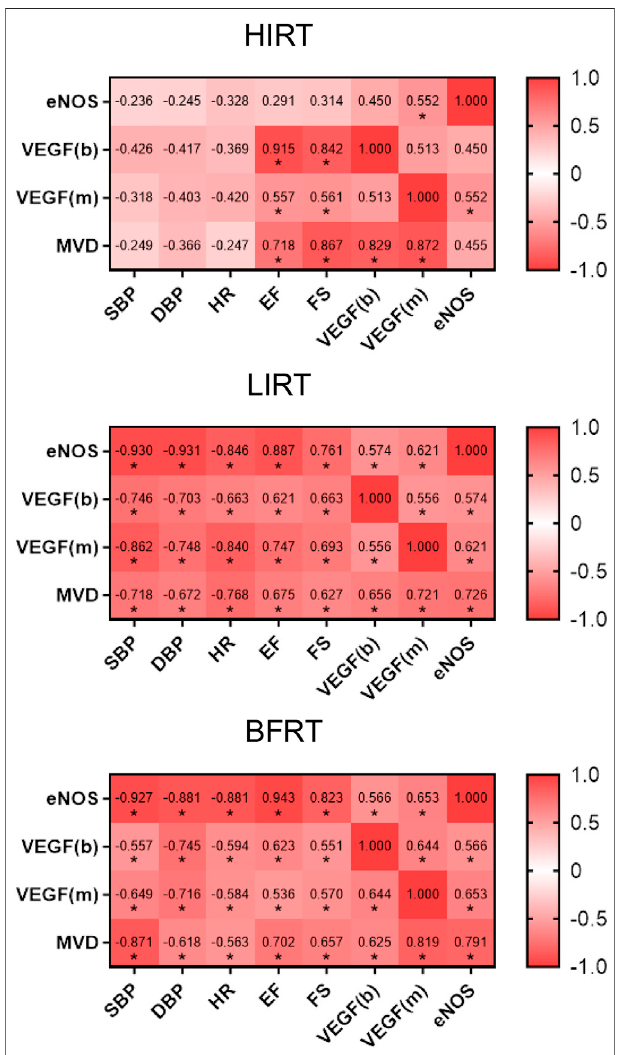
FIGURE 6 | Data correlation